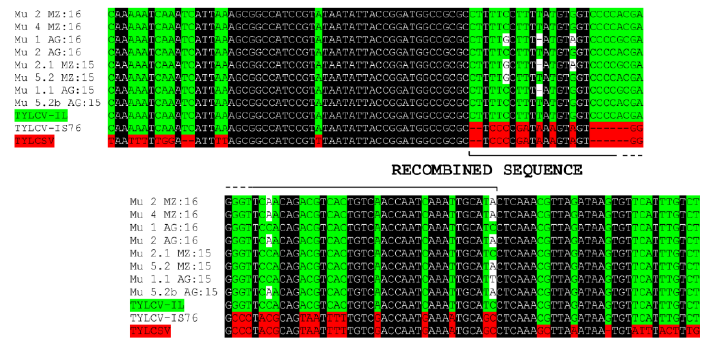
Figure 3. Alignment of the TYLCV and TYLCSV intergenic regions including the recombination event described for TYLCV-IS76 [31]. Sequences labeled with Mu were determined in this work and belong to the so-called Group 2. Conserved sequences are highlighted in black; those corresponding to TYLCV or TYLCSV are marked in green or red, respectively. The line delimits the recombined sequence. Sequences used for the alignment: TYLCV-IL: TYLCV strain Israel (ref. LN846614); TYLCV-IS76: TYLCV recombinant IS76 (ref. LN831187); and TYLCSV: Tomato yellow leaf curl Sardinia virus (ref. KC953604).